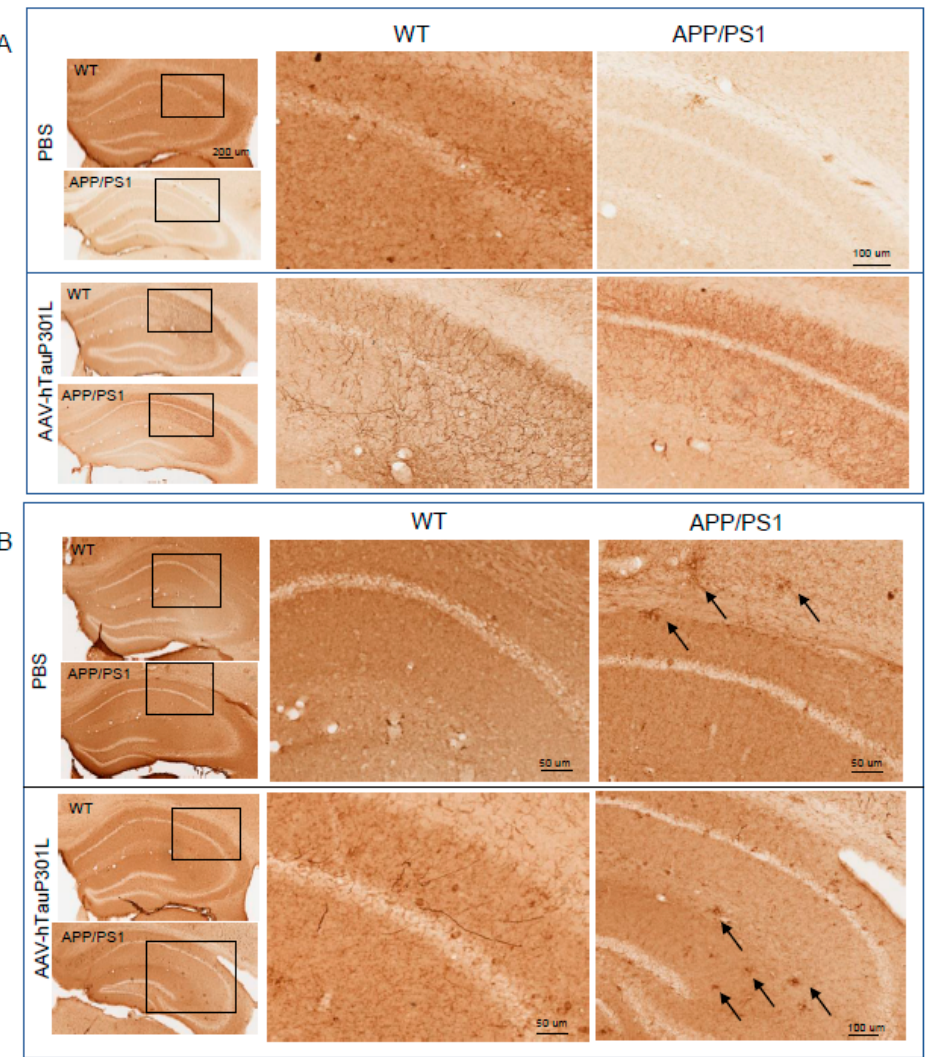
Figure 3. Hippocampal tau and ptau expression using an AAV9-hTauP301L. Wild type (WT) and APP/PS1 mice were injected with PBS or AAV9-hTauP301L in the hippocampus and analyzed 3 months later. ( A ) Representative images showing the expression of human tau (HT7 immunoreac- tivity) in WT and APP/PS1- AAV9-hTauP301L injected mice. No signal was observed in PBS-injected mice. Boxed areas of interest are shown in corresponding right panels. ( B ) Representative images showing ptau (Ser396/404) immunoreactivity using PHF1 antibody in PBS- and in AAV9-hTauP301L-injected mice. Boxed areas of interest are shown in corresponding right panels. In APP/PS1 mice, PHF1 immunoreactivity is evident in the vicinity of amyloid deposits (arrows). Next, to quantify specifically human tau (htau) levels, both qPCR ( n = 3) and Western blot ( n = 5–6) were employed. An important increase of mRNA htau levels was observed in the hippocampi of AAV-hTau injected mice when compared to their respective PBS- controls groups, in both WT ( p < 0.01, Student t test) and APP/PS1 mice ( p < 0.05, Student t test). To notice, the increase was more evident and significant in the case of WT than in the APP/PS1 group (Figure 4A). The analysis expression was followed up using total pro- tein extracts (2%SDS) and specific antibodies to detect total, human and murine , tau (using T46 antibody) and phosphorylated forms of tau (using AT8 and PHF1 anitbodies). In this case, although an increase in total tau was observed in both WT- and APP/PS1- hTauP301L injected mice, no significant differences were encountered among the groups in these 2% SDS soluble extracts (Figure 4B). No important changes among groups were neither